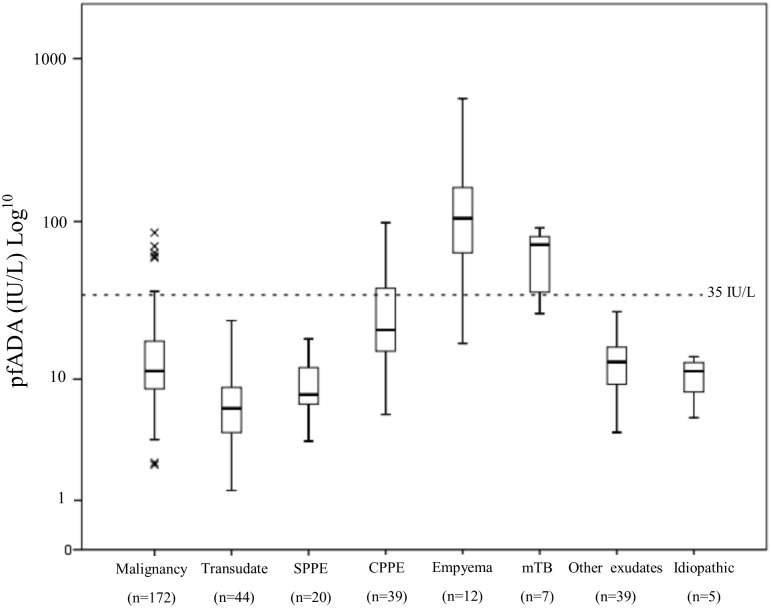
Boxplot of pfADA levels by diagnostic category for all effusions (n = 338).Abbreviations; SPPE—Simple parapneumonic effusion, CPPE—Complicated parapneumonic effusion, mTB—mycobacterium tuberculosis.